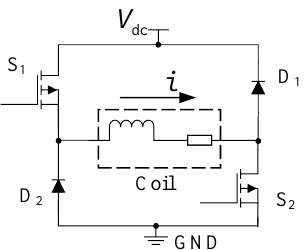
Figure 5. Half-bridge topology of an SPA .